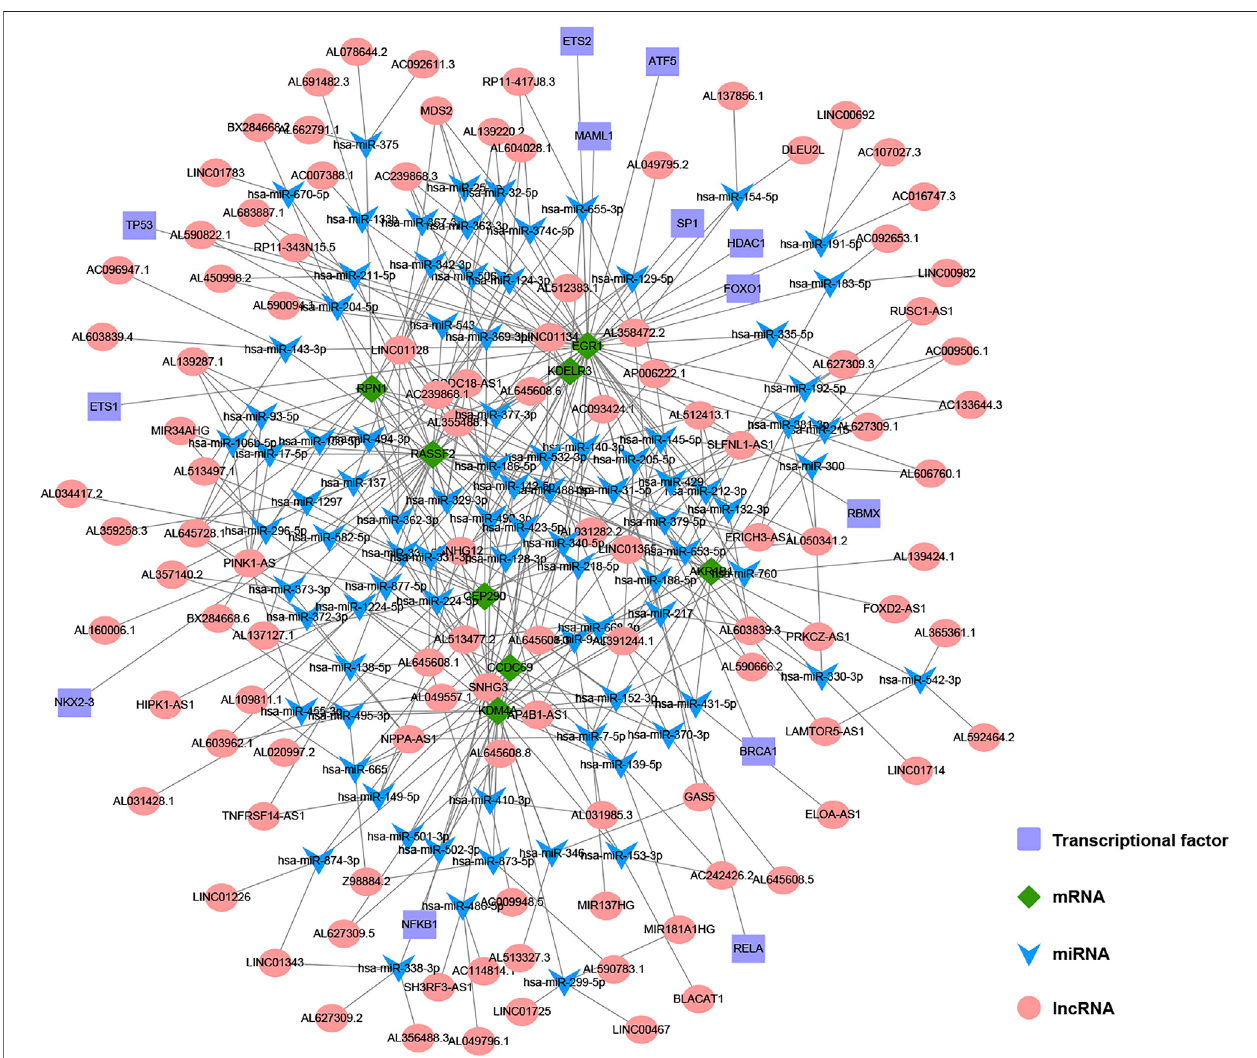
FIGURE 11 | The construction of multi-factor regulatory network of key genes in gastric cancer (GC). Diamond represents mRNA, V-shape represents miRNA, circle represents lncRNA, and rectangle represents TF.